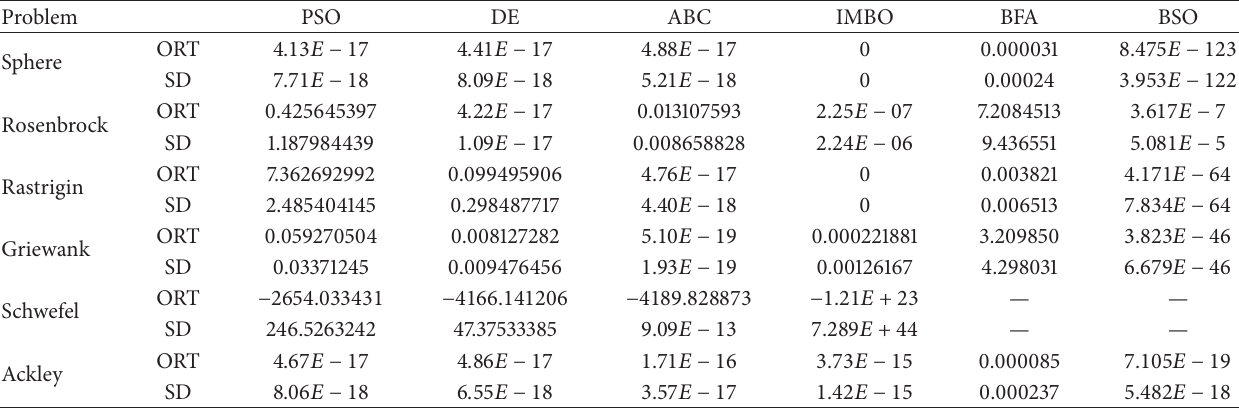
Table 7: The mean solutions obtained by the PSO, DE, ABC, BFA, BSO, and IMBO algorithms for 6 test functions over 30 independent runs and total success numbers of algorithms. Genotype size: 10; (—): not available value, SD: standard deviation, AV: global minimum average.